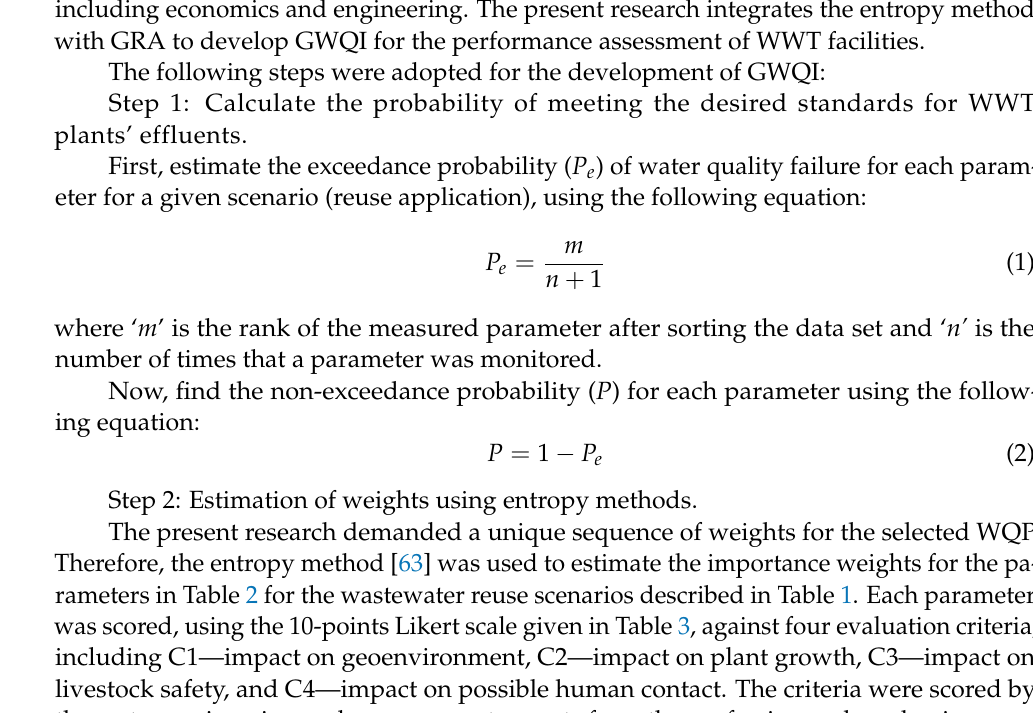
Table 3. The 10-point Likert scale used to score the importance of WQPs and to define priori. Subjective Rating ˆW j Very unimportant 1 Unimportant 3 Average important 5 Important 7 Very important